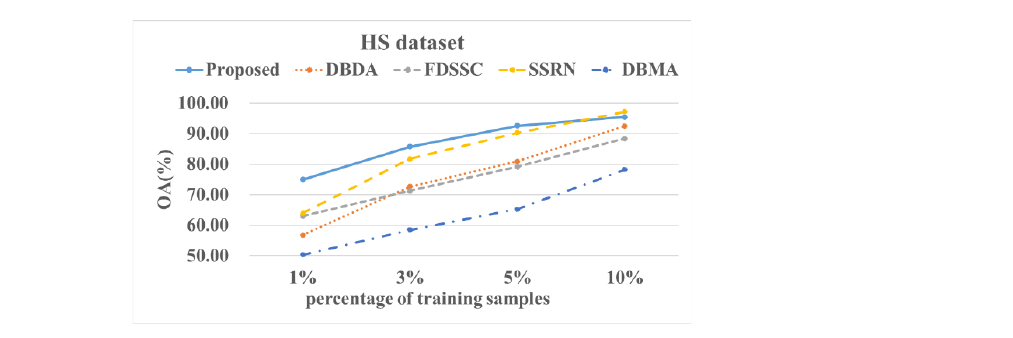
Figure 17. OA results of the different methods from various proportions of training samples using the HS